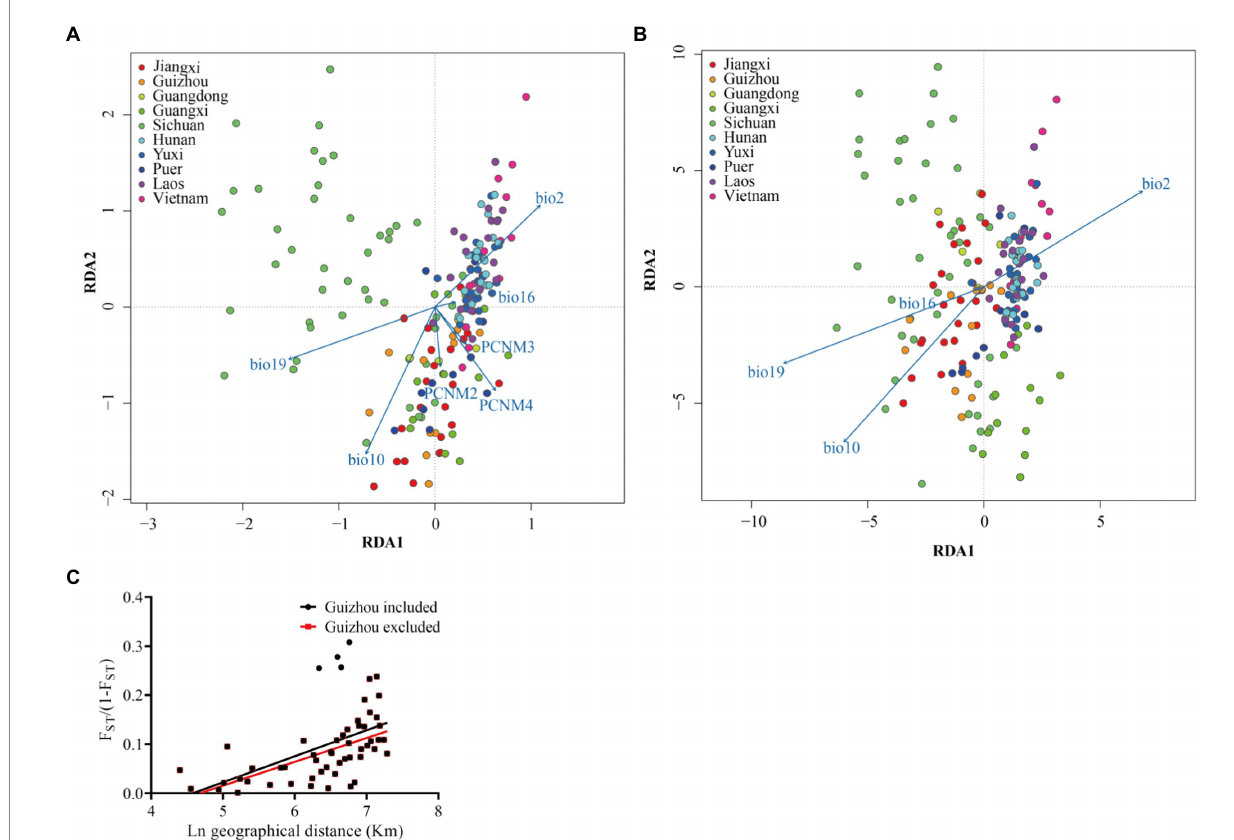
FIGURE 5 The correlation analysis of genetic variability and geographic and climatic variables in the bamboo grasshopper. (A) RDA analysis on genetic variance explained by the environmental effects of climate. A full RDA model was run by considering environmental and geographic effects simultaneously (A) , and a partial RDA model was run by constraining geographic effects to analyze the correlation of environmental variables (B) . Individuals from the same population are indicated by circles with the same color. PCNM2-4, geographic variables; BIO2, mean monthly temperature range; BIO10, mean temperature of warmest quarter; BIO16, precipitation of wettest quarter, and BIO19, precipitation of coldest quarter. Correlations of each variable are indicated by an arrow. Long arrows indicate a high correlation between the variable and genetic distance. (C) Correlation between geographic distance and genetic differentiation (as measured by F ST ) among 10 geographic populations based on Mental test. Black line represents linear correlation analysis of all samples ( r = 0.515, p < 0.001). The red four points indicate all samples excluding between Guizhou and four populations in SE-Asia Group ( r = 0.607, p <